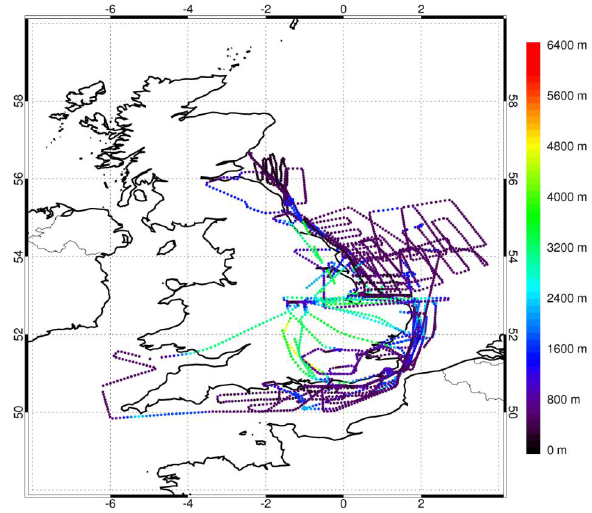
Fig. 1. Locations of the BAe 146 aircraft during the RONOCO cam- Figure 1: Locations of the BAe146 aircraft during the RONOCO campaign for which measurements of paign for which measurements of HO 2 * and NO 3 or N 2 O 5 are HO 2 * and NO 3 or N 2 O 5 are available, coloured by altitude. available, coloured by